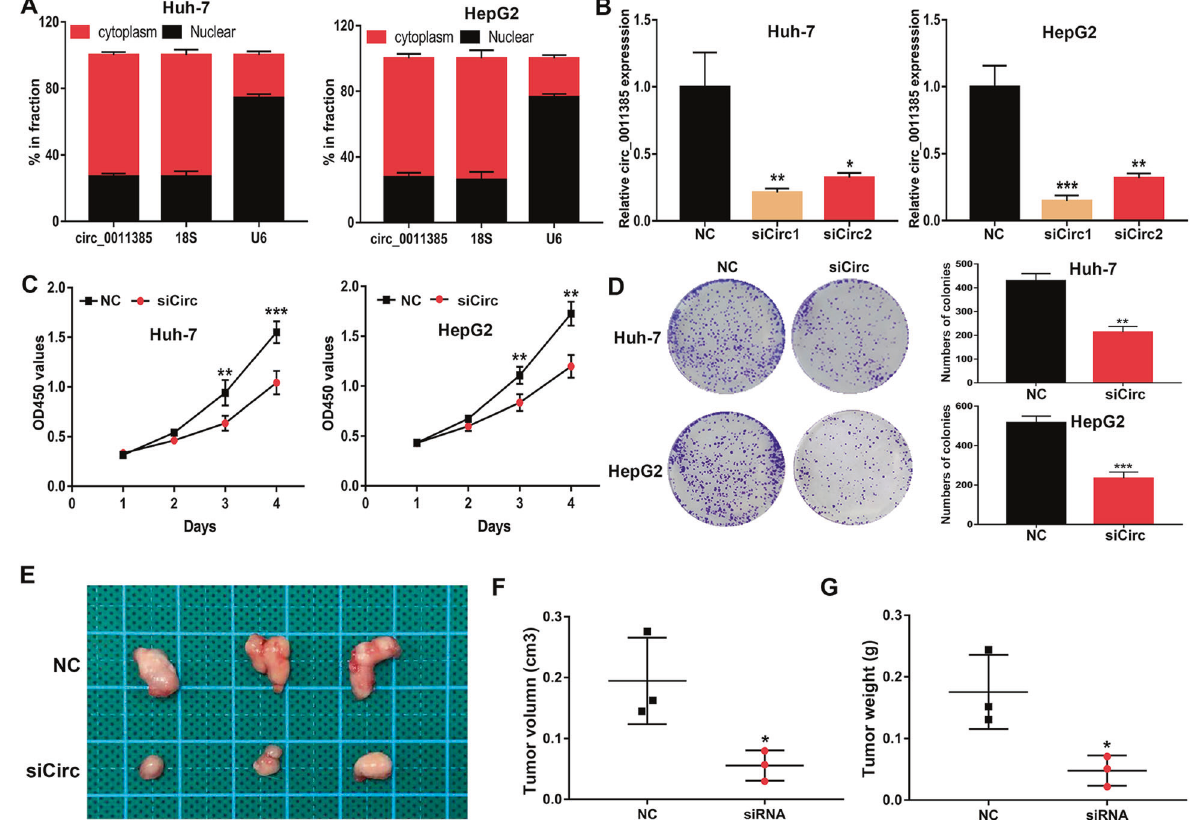
Fig. 2 Knockdown of circ_0011385 hinders the proliferation of HCC cells. A Nuclear and cytoplasmic mRNA fraction experiment, displaying the location of circ_0011385 in Huh-7 and HepG2 cells. B The expression levels of circ_0011385 in transfected Huh-7 and HepG2 cells. C , D CCK-8 and colony formation assays evaluating cell proliferative effects of circ_0011385 in Huh-7 and HepG2 cells. E – G Image of xenograft tumors. Tumor volume and tumor weight were measured in the control and circ-0011385 groups ( n = 3/group). Data ( n = 5) are the means ± SD. * P < 0.05, ** P < 0.01, *** P <